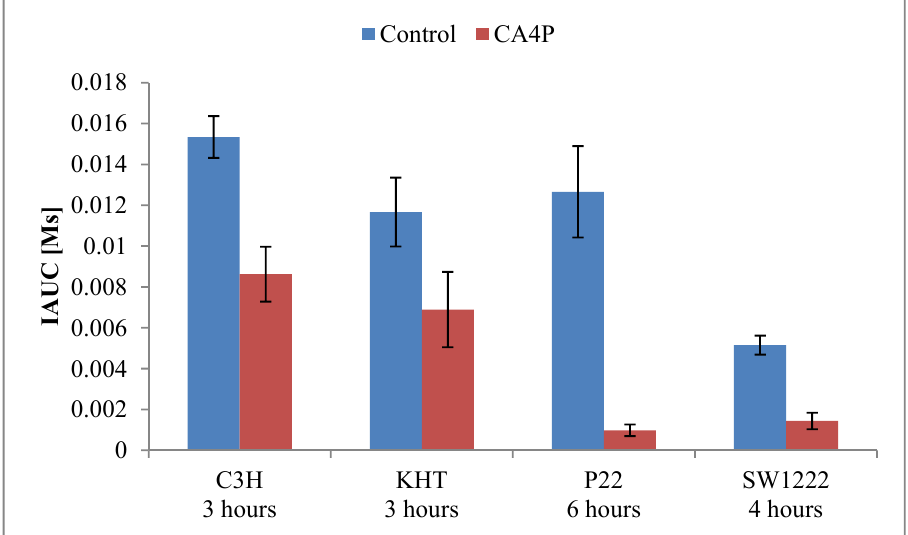
Figure 2. Effect of CA4P (100 mg/kg) as measured by IAUC (90 or 94 s from concentration time curves) following injection of gadopentetate dimeglumine (0.1 mmol/kg) in 4 tumour models: C3H mammary carcinoma [117], KHT sarcoma [117], P22 carcinosarcoma [70], and SW1222 human colonic adenocarcinoma [115]. Bars show mean of tumour mean or median values ±